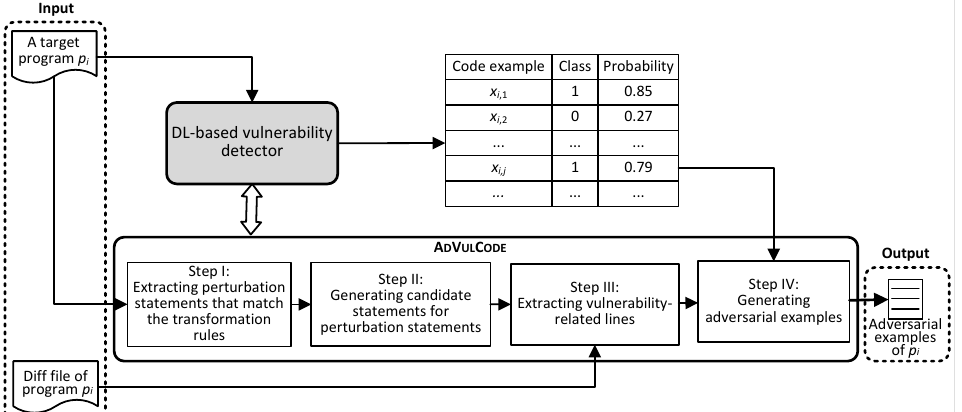
Figure 2. General overview of A D V UL C ODE , where the inputs are source program p i and diff files, and the output is the adversarial examples of the program p i .